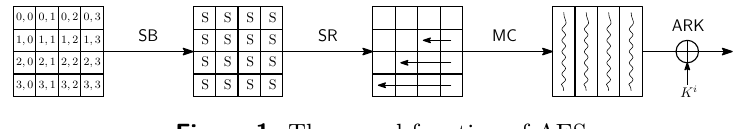
Figure 1: The round function of